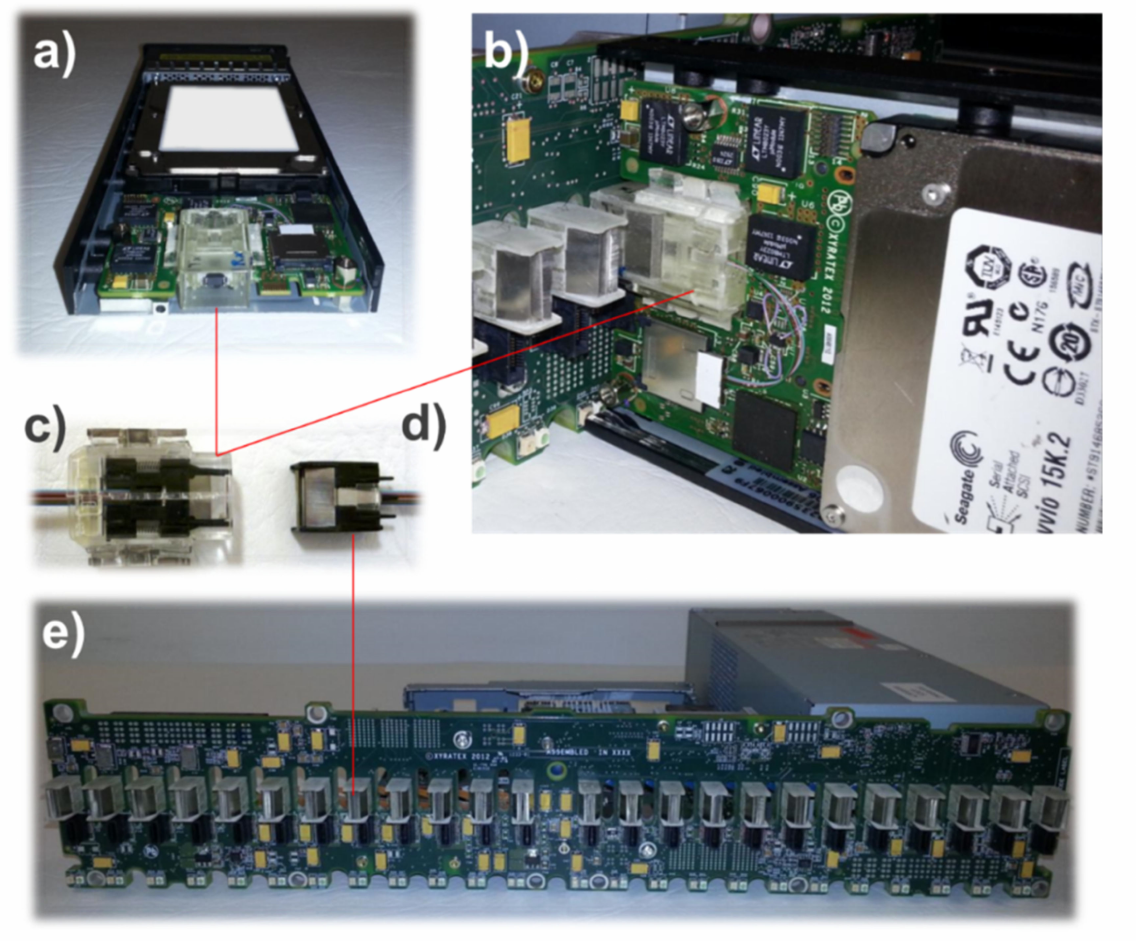
Figure 11. Optical disk drive interface card connectivity: ( a ) optical disk drive interface card as- sembled into a disk drive carrier connected to a hard disk drive, ( b ) interface card enabled disk drive carrier connecting to an electro-optical midplane, ( c ) MorningStar optical connector plug, ( d ) MorningStar optical connector receptacle, ( e ) electro-optical midplane with MorningStar recepta- cles highlighted